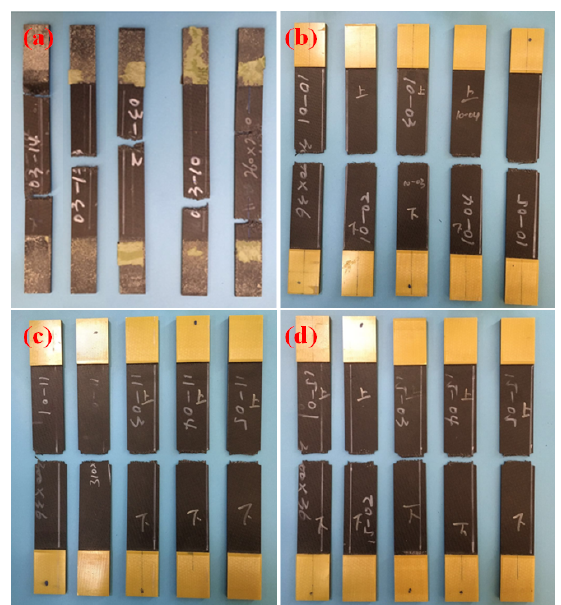
Figure 4: View of specimens after tensile test (a) No damage (b) 2mm depth of notch (c) 3mm depth of notch (d) 4mm depth of notch